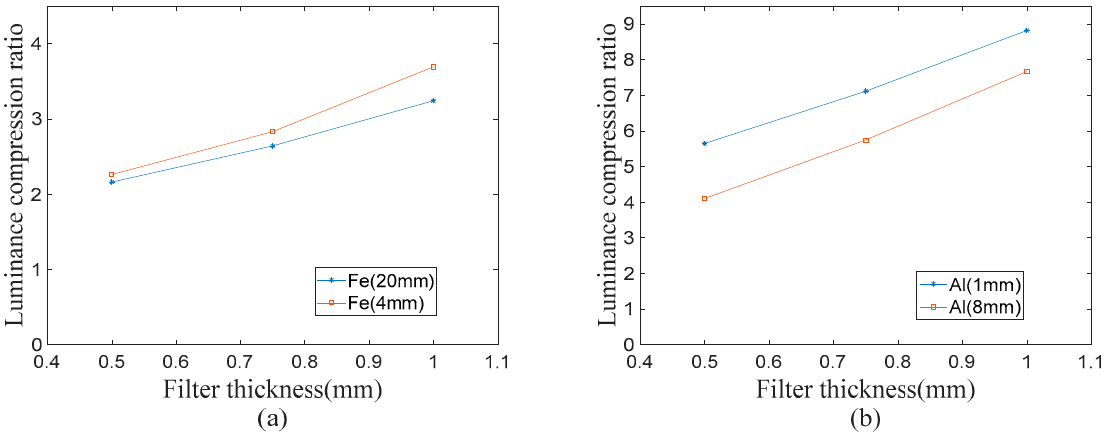
Figure 5. Relation curve between image brightness compression ratio and filter thickness: ( a ) 180 kV iron brightness compression ratio change curve and ( b ) 90 kV aluminum brightness compression ratio curve.